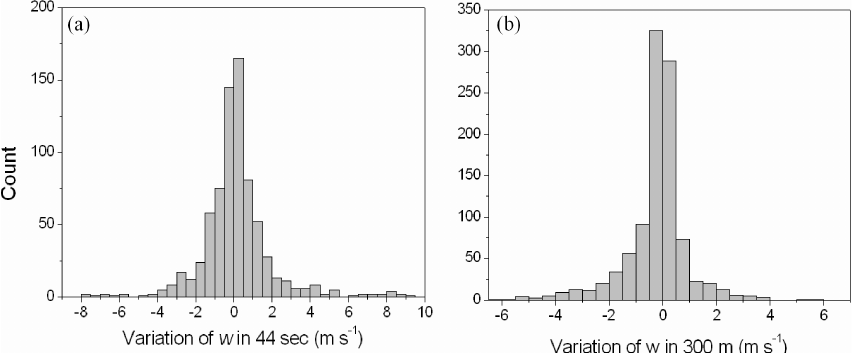
Fig. 9. Distributions for the variation of w (a) in 44s and (b) in 300m,